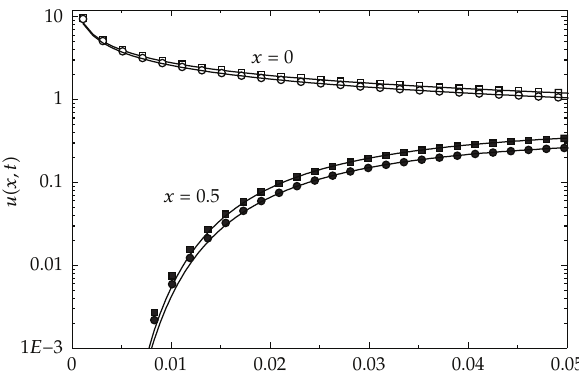
Figure 1: Numerical solution at the mid-point x (cid:7) 0 (cid:5) hollow symbols (cid:6) and x (cid:7) 0 . 5 (cid:5) filled symbols (cid:6) of the fractional cable equation for γ 1 (cid:7) 1 and γ 2 (cid:7) 1 (cid:5) squares (cid:6) and γ 2 (cid:7) 1 / 2 (cid:5) circles (cid:6) with Δ x (cid:7) 1 / 20, Δ t (cid:7) 10 − 4 , K (cid:7) μ (cid:7) 1, and L (cid:7) 5. Lines are the exact solutions given by (cid:5) 2.14 (cid:6) .